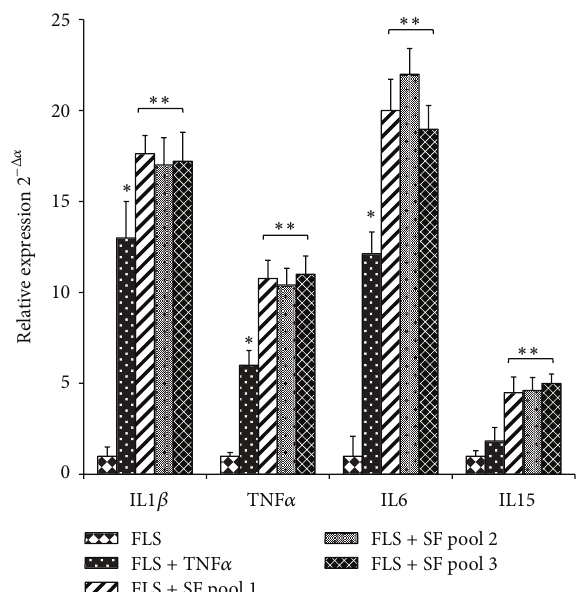
Figure 3: Effects of synovial fluid and TNF 𝛼 on mRNA expres- sion of proinflammatory cytokines in RA fibroblast-like synovial cells. FLS were incubated in absence (FLS) or presence of TNF 𝛼 (25 ng/mL) (FLS + TNF) or three different synovial fluid pools (FLS + SF) (1:8 dilution in culture medium). After 7 days cells were analysed for IL1 𝛽 , IL6, IL15, and TNF 𝛼 mRNA expression by quanti- tative RT-PCR. Data were analysed according to the comparative Ct methodandwerenormalizedbyGAPDHexpressionineachsample. Relative mRNA levels were calculated based on the Ct values, corrected for GAPDH expression, according to the equation: 2 −Δ Ct [ Δ Ct = Ct(TNF 𝛼 , IL1 𝛽 , IL6, or IL15) − Ct(GAPDH)]. Data are expressed as mean ± SD. ∗ 𝑃 < 0.05 versus FLS; ∗∗ 𝑃 < 0.05 versus FLS + TNF 𝛼